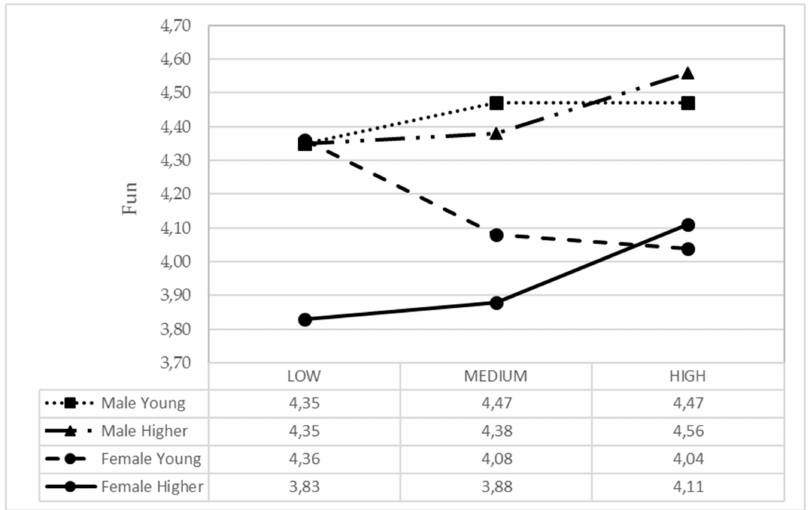
Figure 6. Means of the IPAF4 parental style based on the adolescent gender and age for fun.